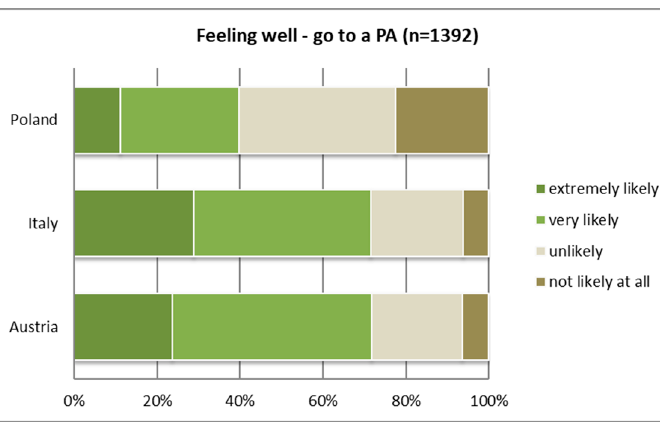
Figure 10. Likelihood of going to a protected area when feeling well (mentally and physically).